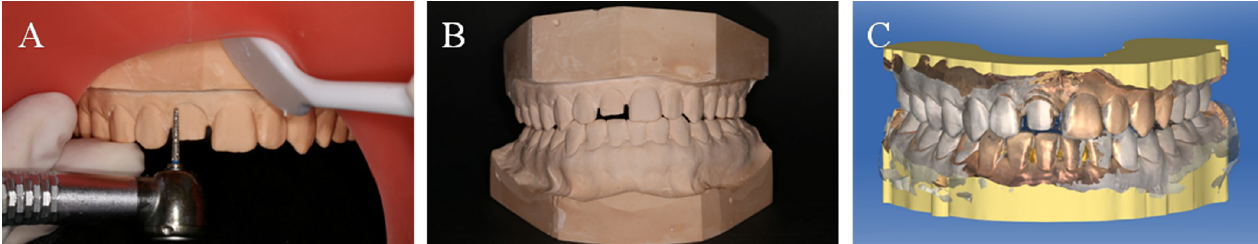
Fig 2. Preparing the right maxillary central incisor (11) (A), the Gypsum model of the preparation (B), the virtual image of the preparation